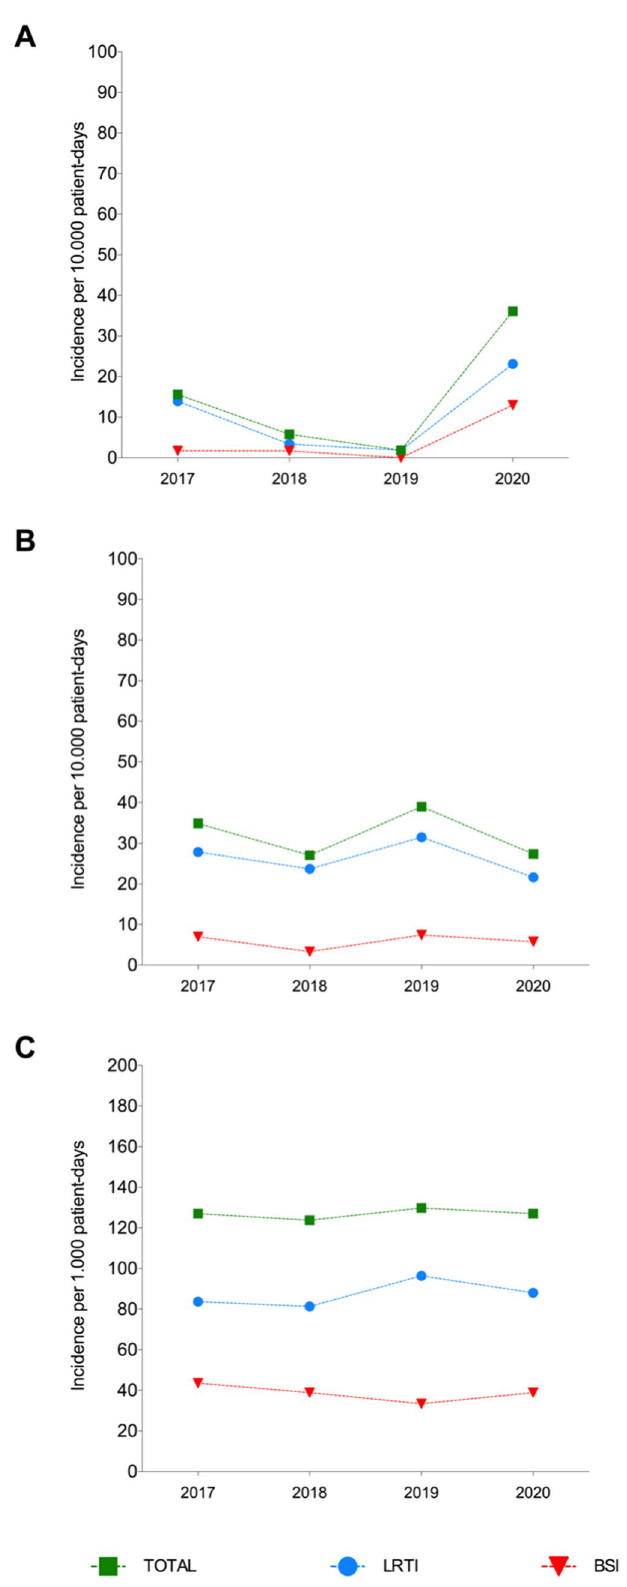
Figure 4. ( a ) Incidence rate of ICU-acquired infection due to Carbapenem-resistant Acinetobacter baumannii (CR-Ab) per 10.000 patient-days over the same 4-months period (January–April) from 2017 to 2020. ( b ) Incidence rate of ICU-acquired infection due to Pseudomonas aeruginosa and ( c ) carbapenemase-producing Enterobacteriaceae (CPE). Abbreviations: Lower Respiratory Tract Infection, LRTI; Bloodstream Infection